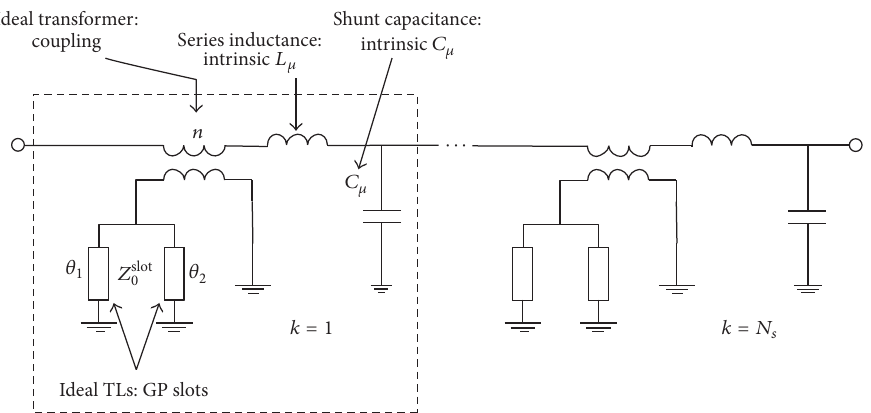
Figure 9: Circuit model for the slotted ground plane microstrip structure using ideal transformer [35].